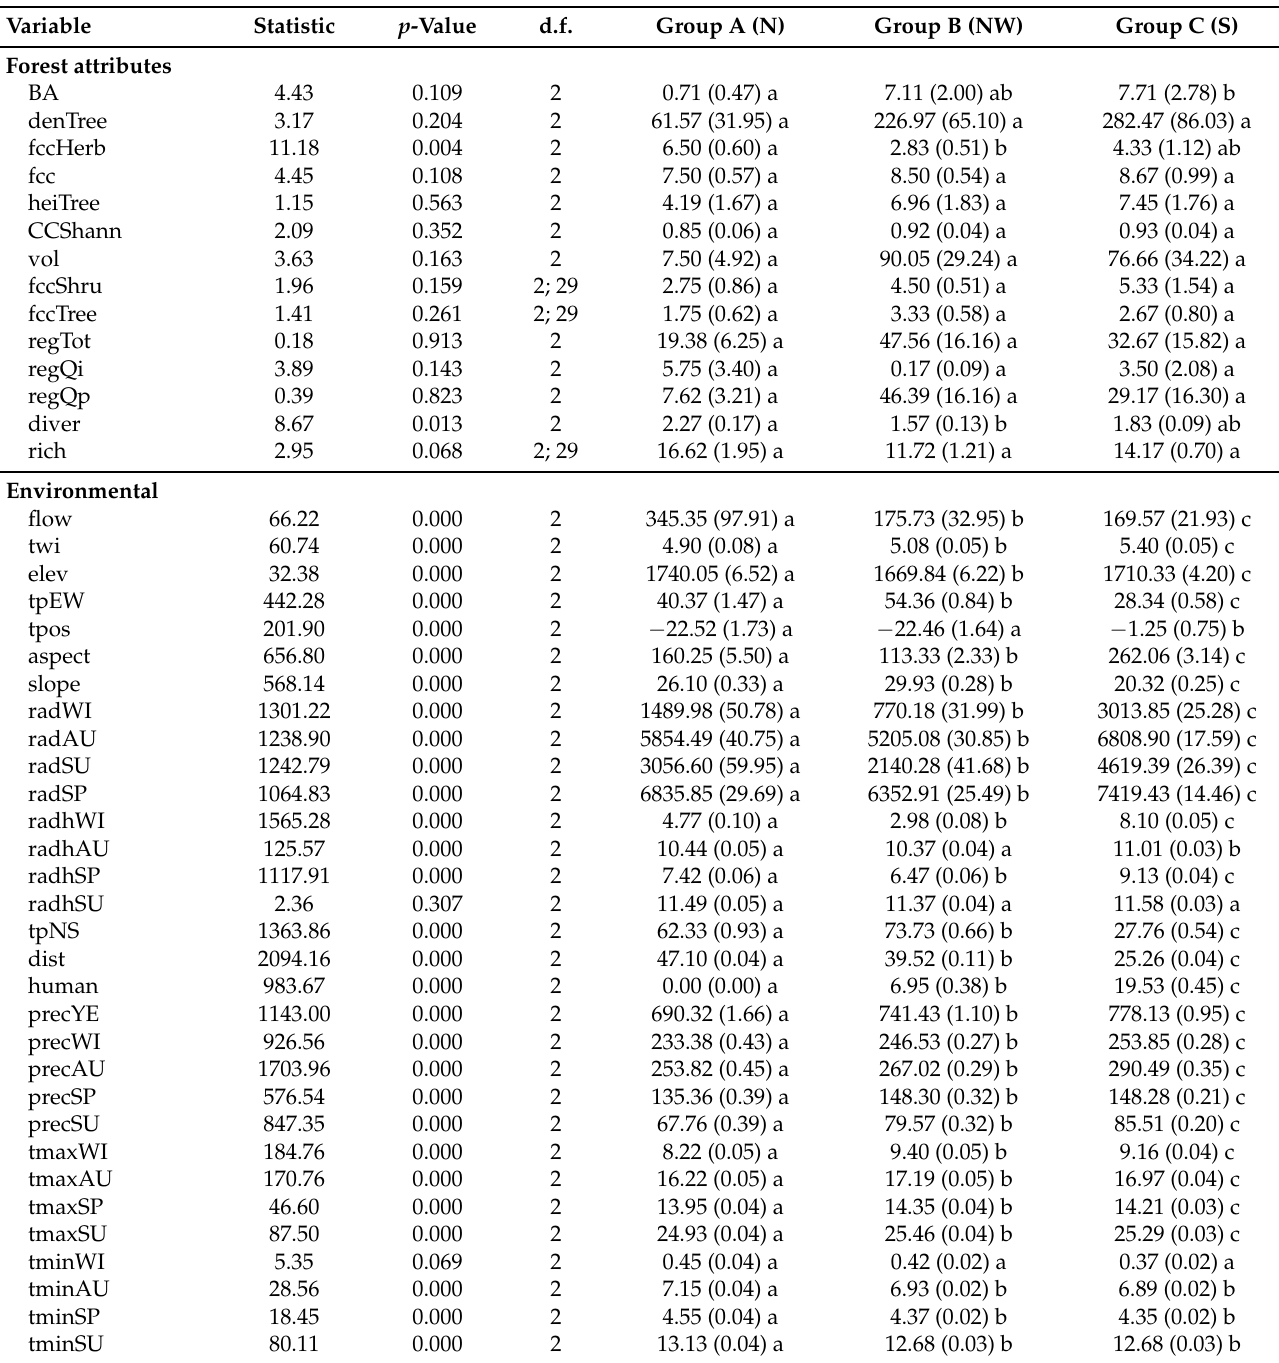
Table 4. Mean values of environmental variables and forest attributes for the three identified clusters of Q. pyrenaica forests derivated from the discriminant analysis. The Chi-squared statistics of the nonparametric Kruskal–Wallis test are shown except for those variables analyzed using ANOVA test (fccShru, fccTree and rich). Values within brackets correspond to standard errors. Standard errors are shown in parentheses. Different letters indicate statistically significant differences between clusters’ oak